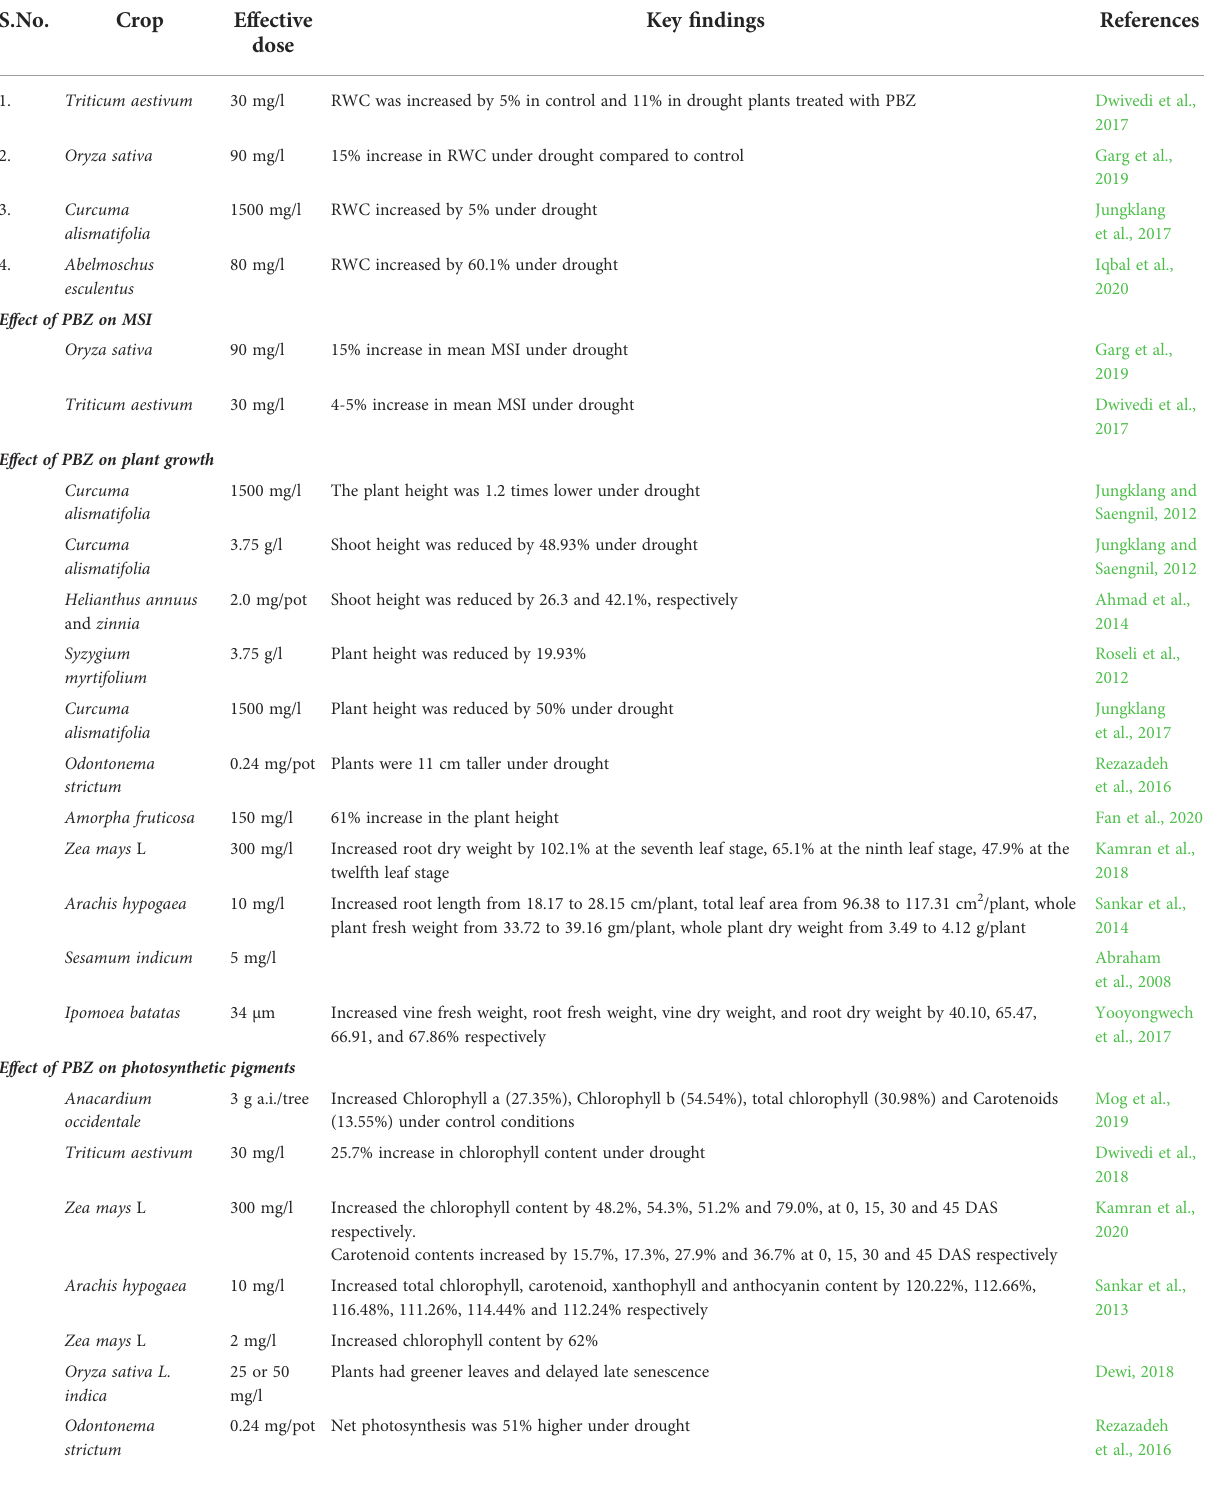
TABLE 1 Summary of effect of PBZ on different parameters under the drought stress in various crops species. Effect of PBZ on